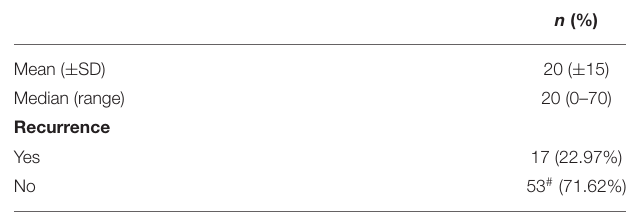
TABLE 1 | Clinicopathological features of all patients ( n = 74).